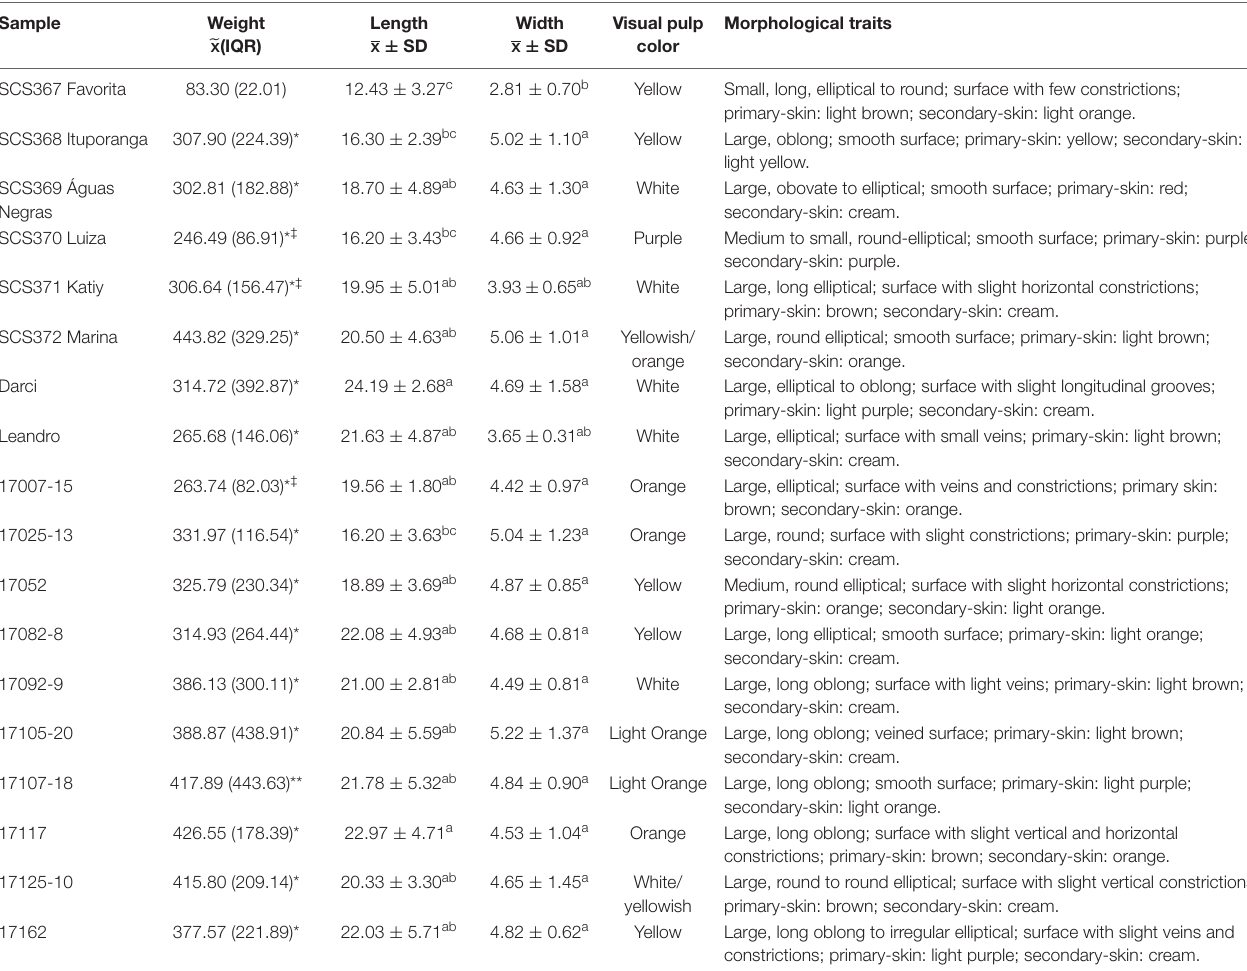
Different symbols in the weight column show significant differences between samples with 95% certainty by Kruskal–Wallis/Nemenyi tests. Different letters in length and width columns show significant differences between samples with 95% certainty by ANOVA/Tukey. e x (IQR), median and Interquartile Range. x ± SD, mean and standard